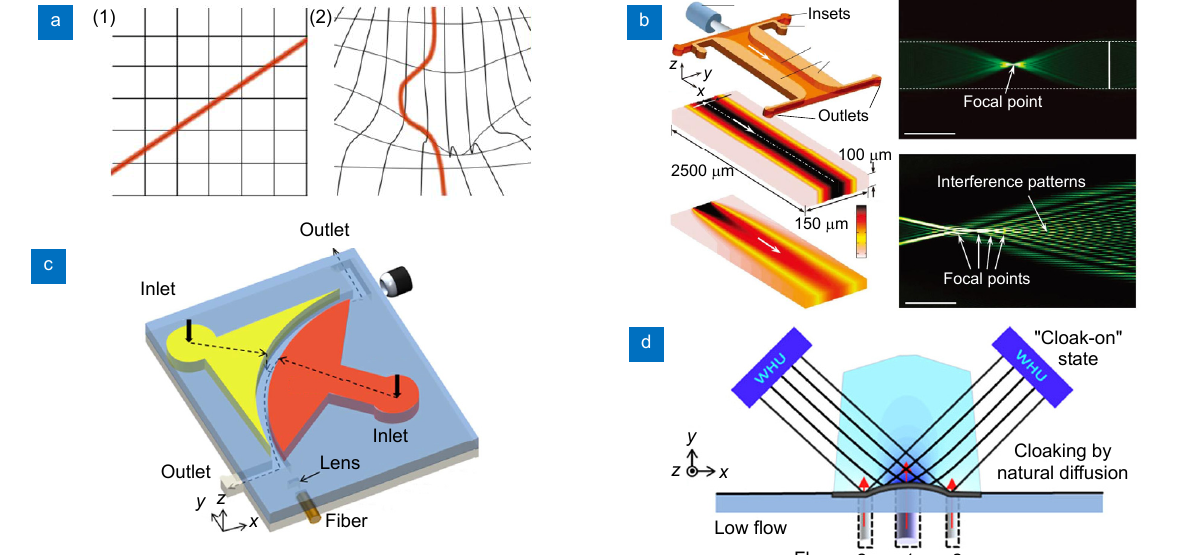
Fig. 4 | ( a ) (1) Light propagates in a straight way in homogeneous liquid medium. (2) Light bends in inhomogeneous liquid medium. ( b ) The schematic diagram and experimental images of optofluidic waveguide based on QCTO, which can focus light. ( c ) A QCTO optofluidic waveguide, bending light at 90°, 180°, and 270°. ( d ) A tunable liquid cloaking. Figure reproduced from: ( b ) ref. 39 , Macmillan Publishers Limited; ( c ) ref. 40 , Optical Society of America; ( d ) ref. 41 , WILEY-VCH Verlag GmbH & Co. KGaA,